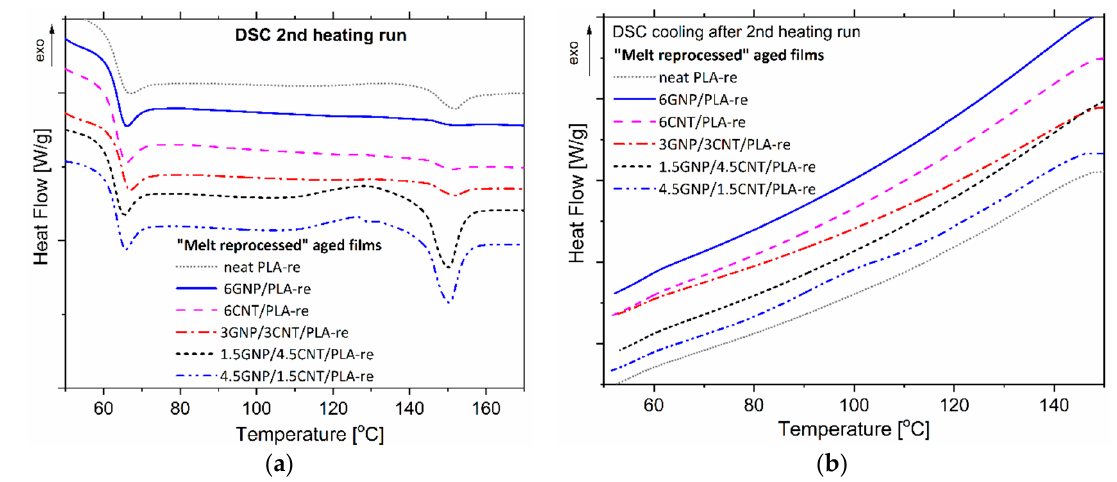
Figure 5. DSC thermograms of “melt reprocessed” aged films and 200 °C: ( a ) DSC second heating run at a rate of 20 °C/min, and ( b ) subsequent fast cooling with a rate of 20 °C/min.